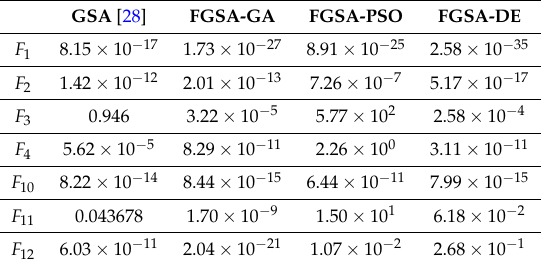
Table 8. Comparison between FGSA-GA and revised GSA over 16